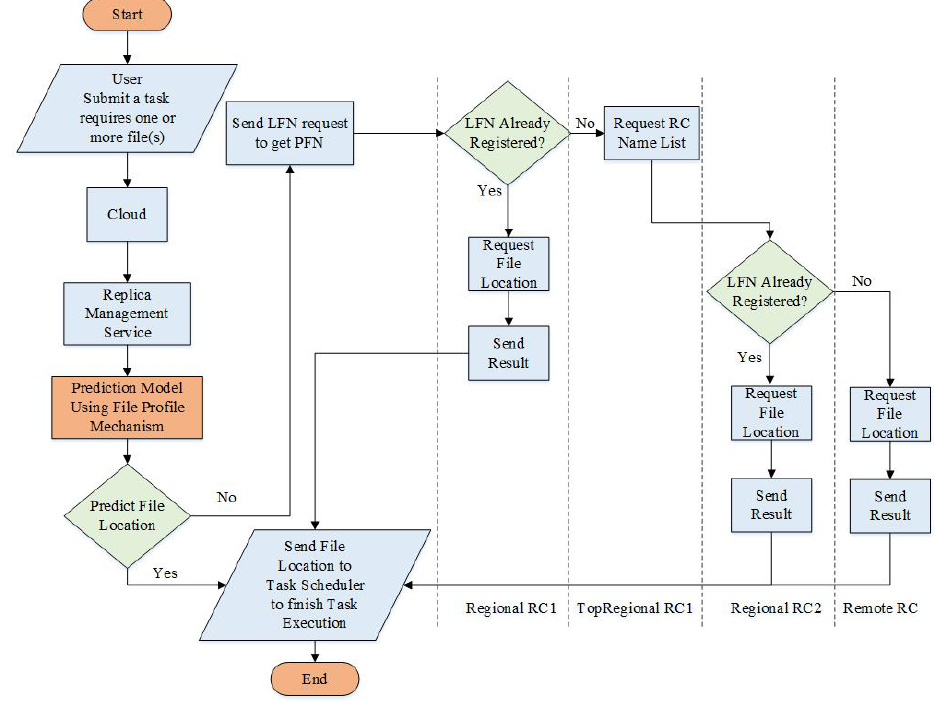
Figure 2. Replica prediction and selection